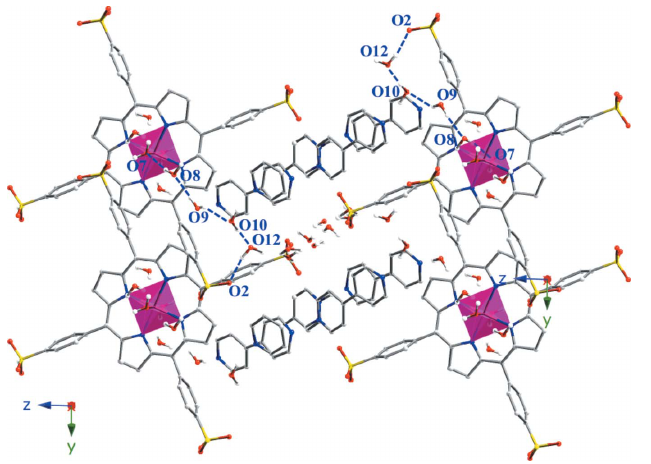
Figure 1 Crystal-structure packing for compound 1 . Colour code: Mn pink, C grey, N blue, O red and S yellow. H atoms have been omitted for clarity.